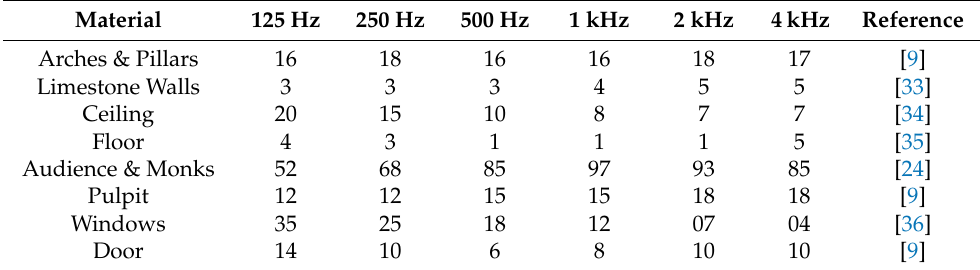
Table 2. Absorption coefficients used in model.